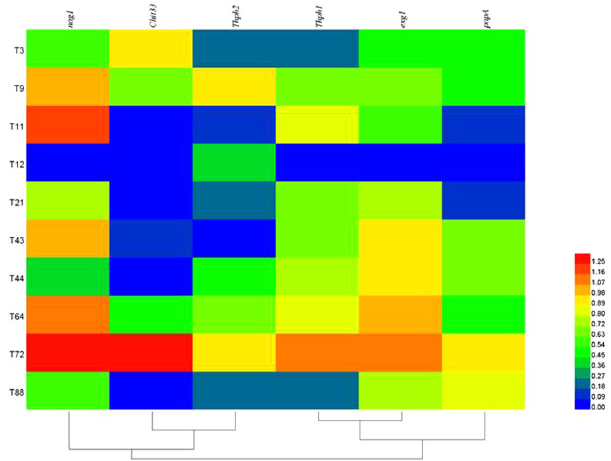
Figure 1. Heat map and clustering categorization of mycoparasitism related genes expression. Chitinase ( nag1, Chit33 ), Cellulase ( Thph1 and Thph2 ), 1,3- β -Exoglucanase ( exg1 ), Aspartyl protease ( papA